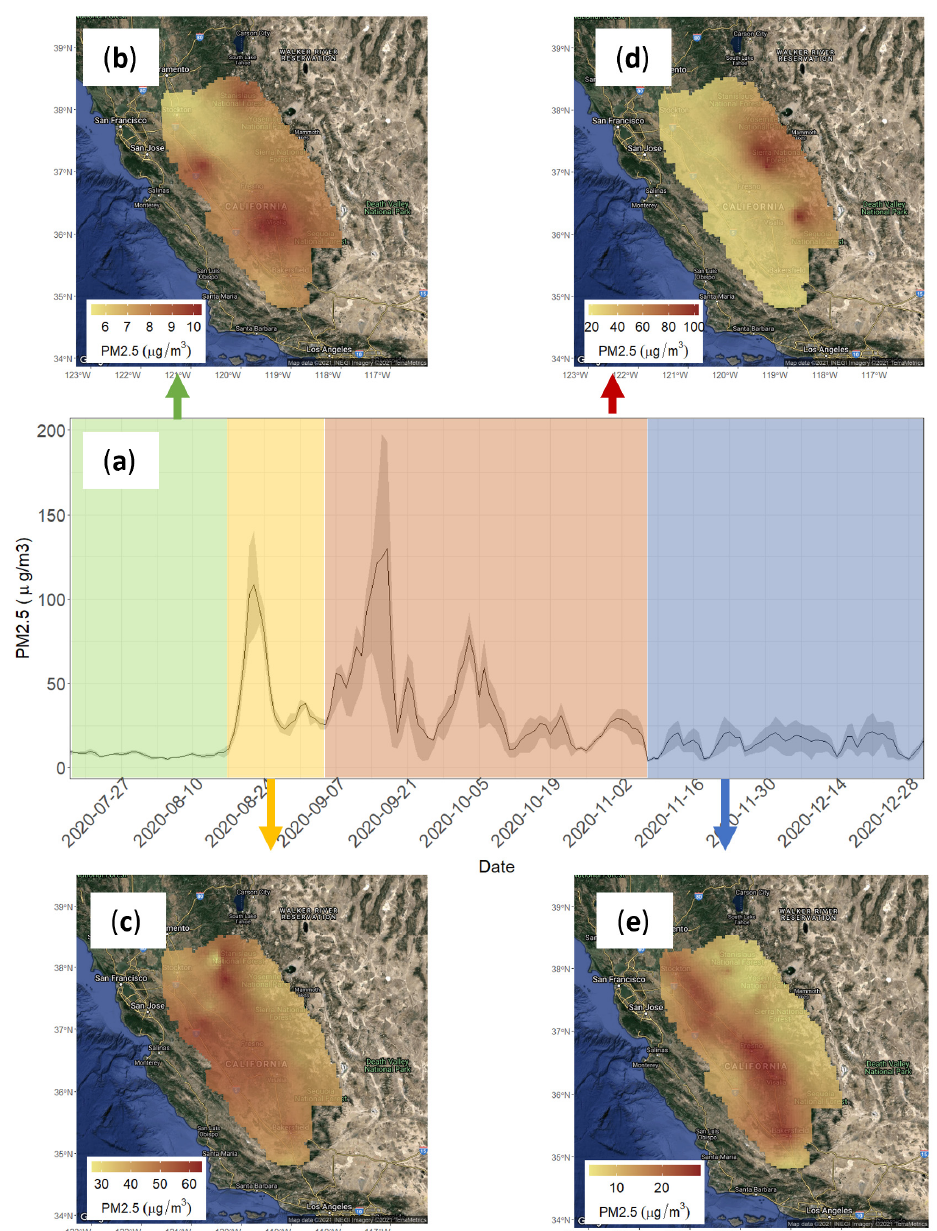
Figure 7. ( a ) Daily average concentration in the study area with shaded areas showing the grids ranges between 25–75% of the concentration levels. ( b ) Average concentration map for the pre-fire period (17 July to 17 August). ( c ) Average concentration map from the start of SCU Lightning Complex to the start of the Creek fire (17 August to 4 September). ( d ) Average concentration map from 4 September to 6 November, ( e ) Average concentration from 6 November to 31 December.